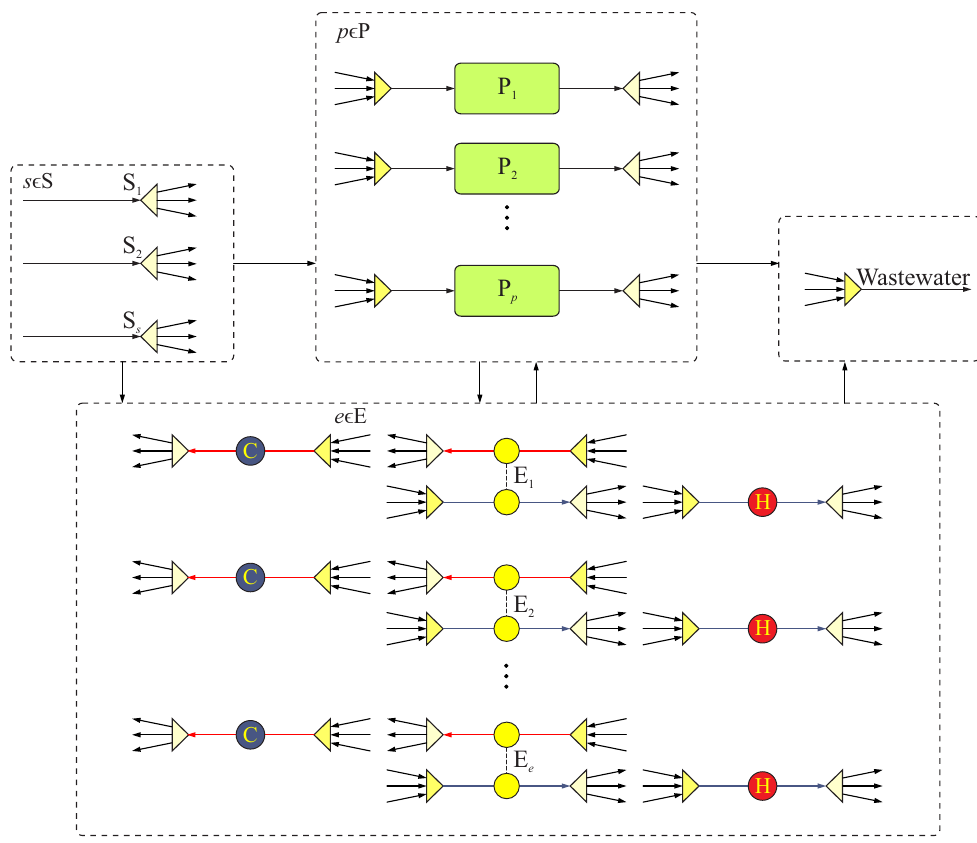
Figure 4. The proposed HIWN